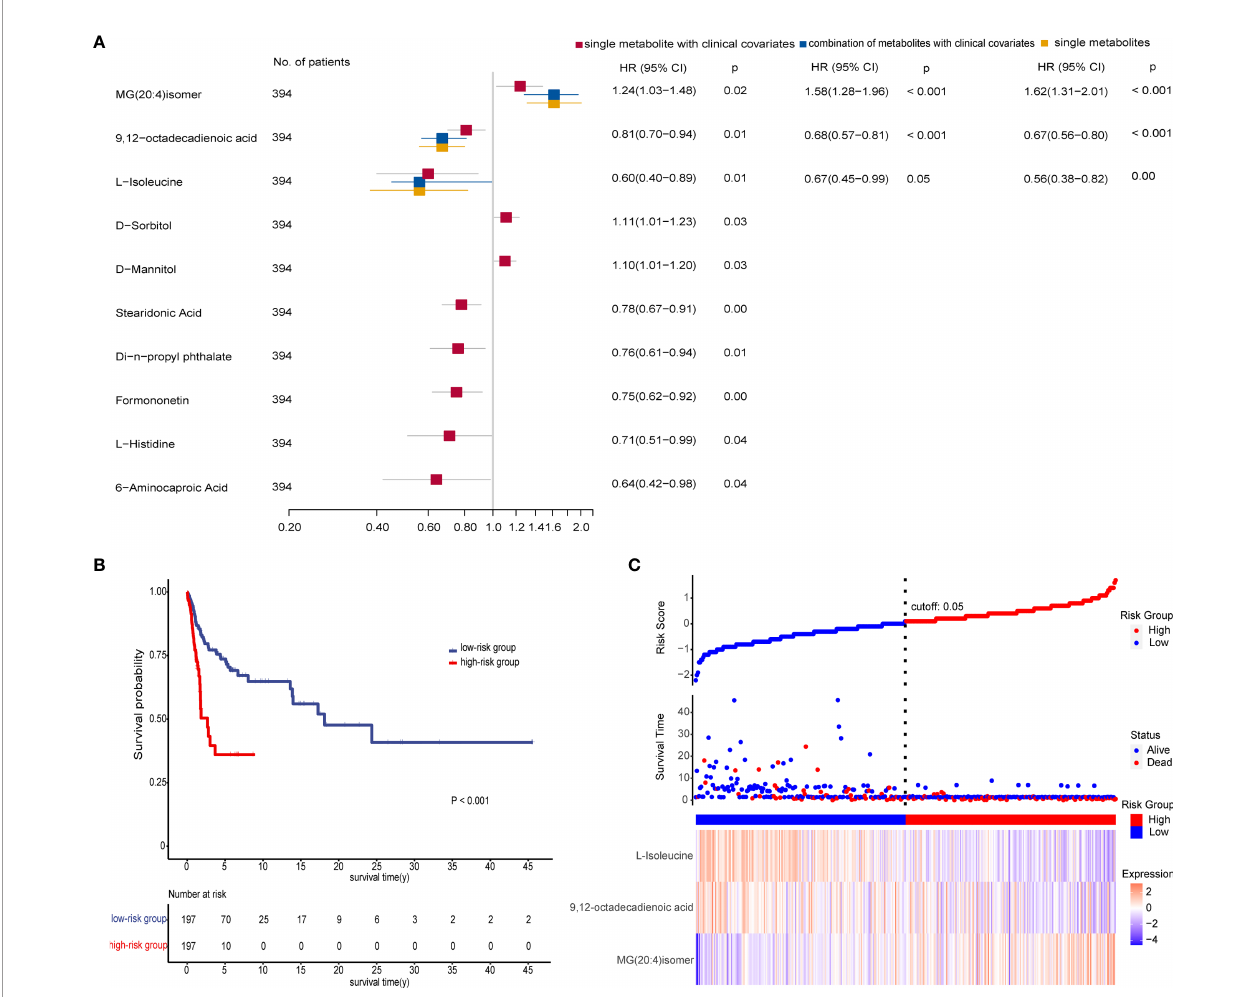
FIGURE 5 | Prognostic value of the metabolite-based model from various multivariate Cox regression analyses on all patients. (A) Forest plot for multivariate Cox regression model of biomarkers with and without clinical factors associated with overall survival (OS) of patients ( n = 394). Hazard ratio (HR) is depicted on the x -axis and each prognostic variable on the y -axis. HR >1 indicates poor prognosis. Black dots indicate point estimates, the horizontal lines represent the 95% CIs, and the vertical dashed line represents the reference line for an HR of 1. (B) Kaplan – Meier plots displaying the signi fi cant difference of overall survival in two patient groups ( p < 0.001). The risk score of the Cox regression model strati fi ed patients into low-risk (blue) and high-risk (red) groups according to median. Numbers of survivors at different time points strati fi ed by risk group are shown in the table below. (C) Risk score analysis consisting of three parts: up part, risk score distribution of the low- risk (blue) and high-risk (red) groups (up); middle part, scatter plots representing the survival status and duration of ESCC cases; down part, heatmap of the relative expression levels of MG(20:4)isomer, 9,12-octadecadienoic acid, and L-isoleucine. See also Table S8